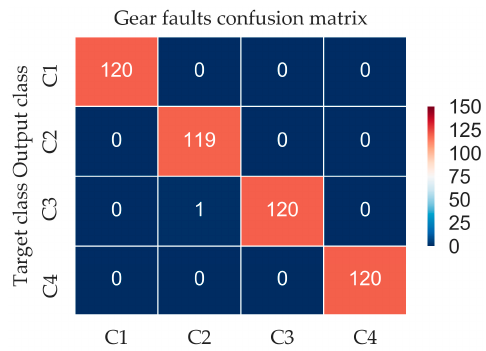
Figure 17. Confusion matrix in gear fault diagnosis.